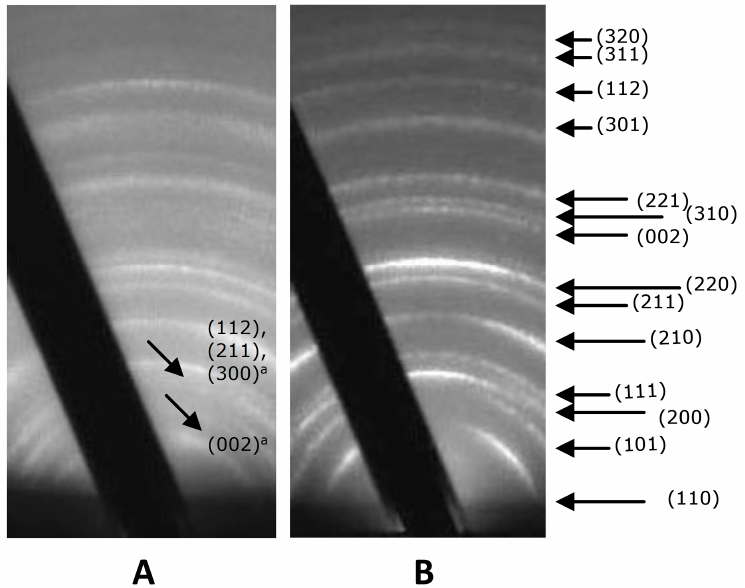
Figure 5. Comparisons of RHEED patterns for ( A ) SiHA1 film on a CPTi disc annealed at 700 ◦ C in flowing argon for 2 h and ( B) CPTi sample annealed in air at 750 ◦ C for 1 h. All indexed planes match to ICDD card 76-1939 (Rutile) unless indexed with a superscript a plus diagonal arrows indicating possible HA reflections matching to ICDD card 09-432 (HA).